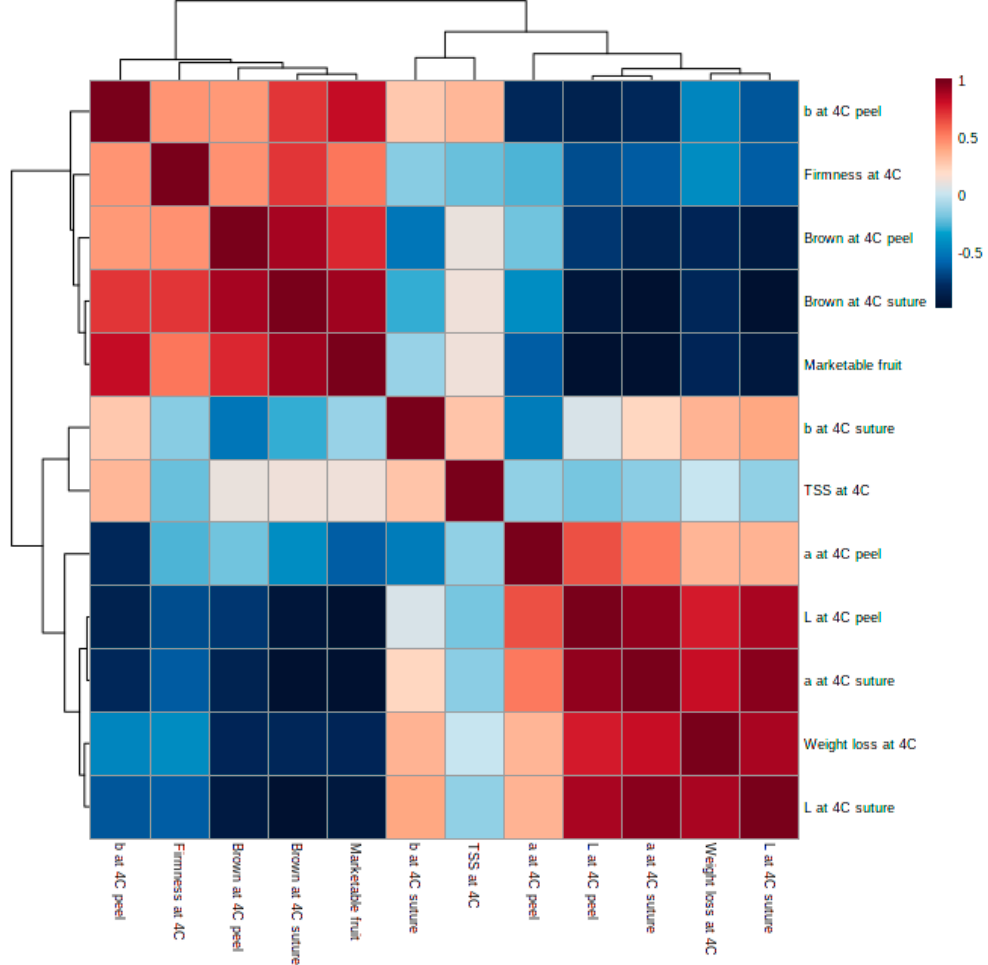
Figure 8. Correlation analysis between various fruit quality parameters during refrigerated storage (4 °C) and transferred to 20 °C for additional two or five days.